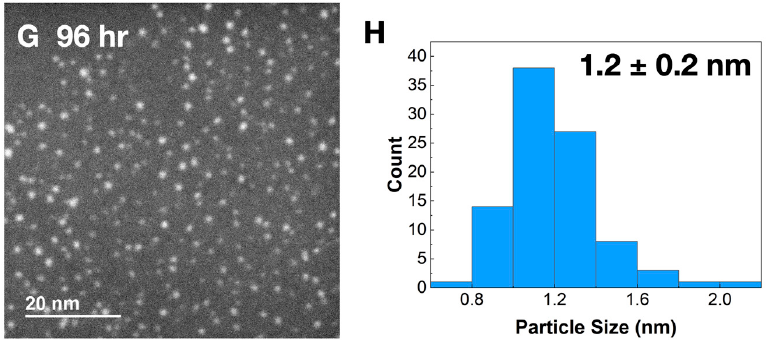
Figure 2. ( A , C , E ) Bright-field TEM image of synthesized Pt nanoparticles after 2, 48, and 96 h of reduction, respectively. ( B , D , F ) Particle size distribution histogram of synthesized Pt nanoparticles after 2, 48, and 96 h of reduction, respectively. The scale bar on panels A, C, and E represents 50 nm. The average particle sizes are listed on the particle size distributions. ( G ) High-angle annular dark-field scanning transmission electron microscopy (HAADF-STEM) image of small Pt nanoparticles after 96 h of reduction. These small particles are not included in the particle size distribution in panel F. The 1.2 nm particles are not observed in the samples reduced for 2 and 48 h. ( H ) Particle size distribution of the smallest particles observed at 96 h of reduction time.